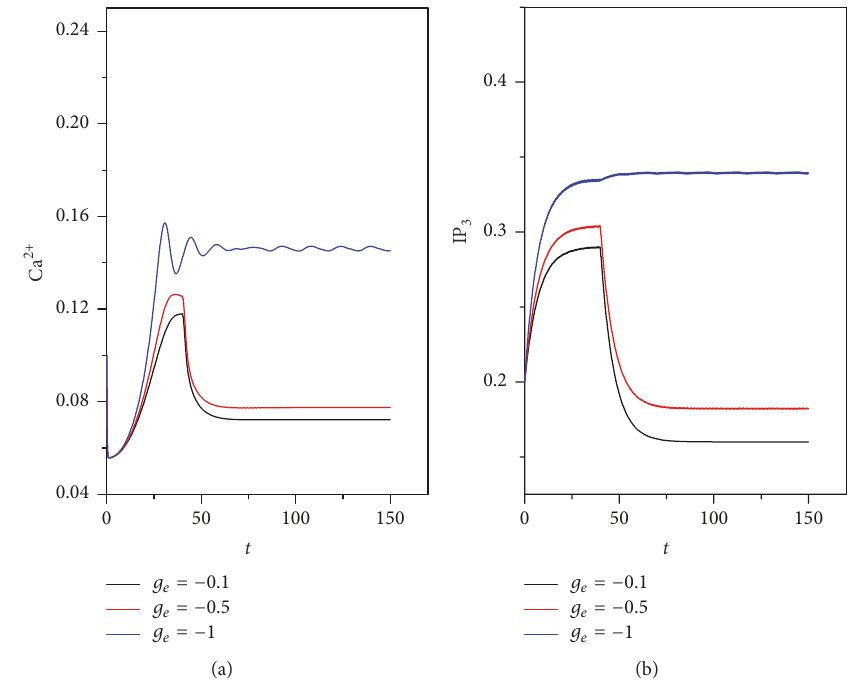
Figure 3: Fluctuation in Ca 2+ concentration and IP 3 concentration is calculated by applying different feedback gains 𝑔 𝑒 in electric autapse with timedelay 𝜏 = 2 . Theparameter isset as 𝑟 IP at 𝑡 < 40